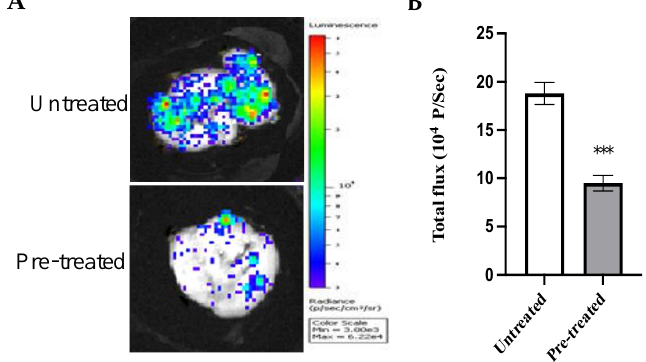
Figure 10. Effect of azilsartan on the in vivo tumor metastatic activity of MDA-MB-231/Luc cancer cells. ( A ) Bioluminescent images for lungs of animals injected with cancer cells untreated or pre- treated with azilsartan. ( B ) The bioluminescent intensities. Bars represent mean ± SD, n = 6. Significant difference was analyzed by student t test, where *** p < 0.001, compared to intensities of the animals injected with untreated cells.